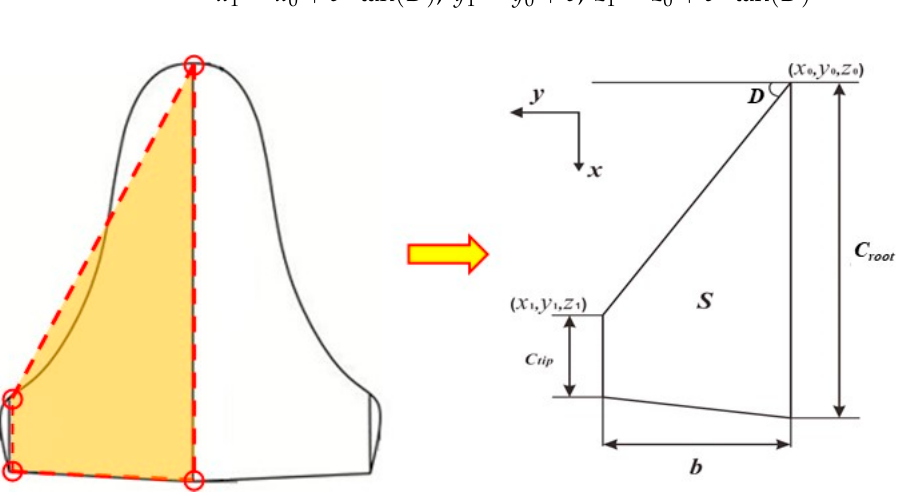
Figure 3. Description of the hypersonic wing.